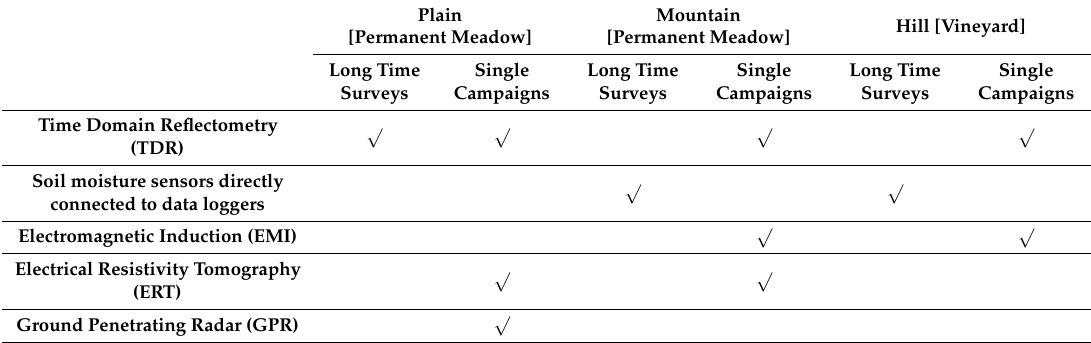
Table 1. Synoptic table summarizing the different equipment used in the different testing sites.